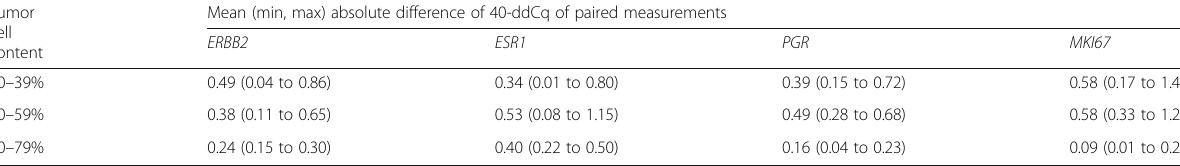
Table 1 Differences in MammaTyper® relative gene expression between pairs of whole tissue and tumor-enriched specimens Tumor cell